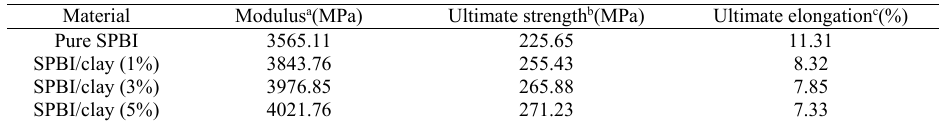
Table 2 Mechanical properties for SPBI and SPBI/clay films. Table 2. Mechanical properties for SPBI and SPBI/clay